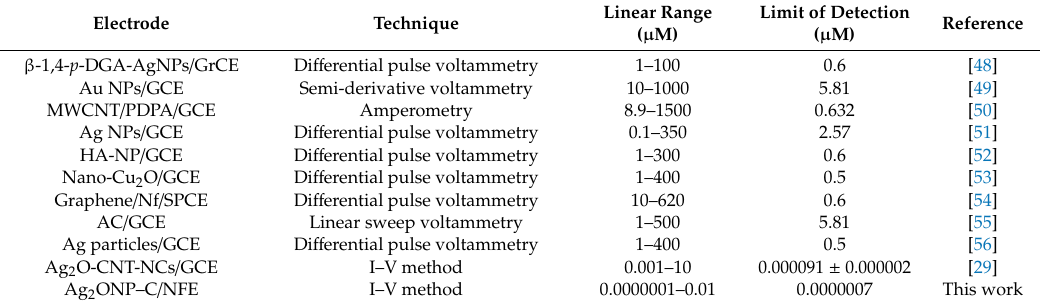
Table 1. Comparison of analytical parameters for detection of p -NP over various modified